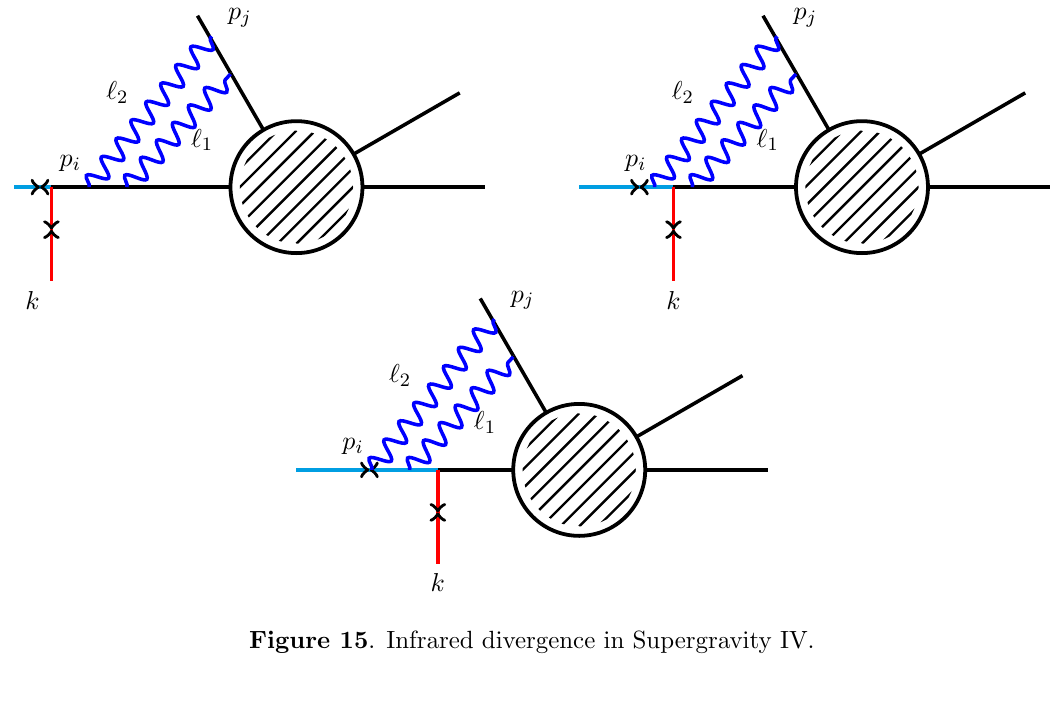
Figure 15 . Infrared divergence in Supergravity